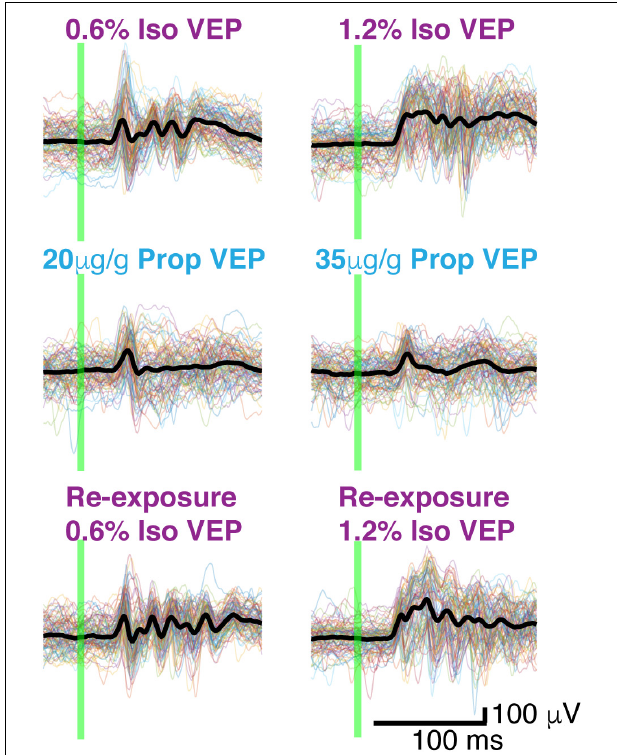
FIGURE 5 | Butterfly plots. Thin colored traces under high and low doses of each anesthetic: isoflurane, propofol, and isoflurane re-exposure in the same animal. Thick black lines represent the average VEP under each dose of each anesthetic. The flash is denoted by the green vertical